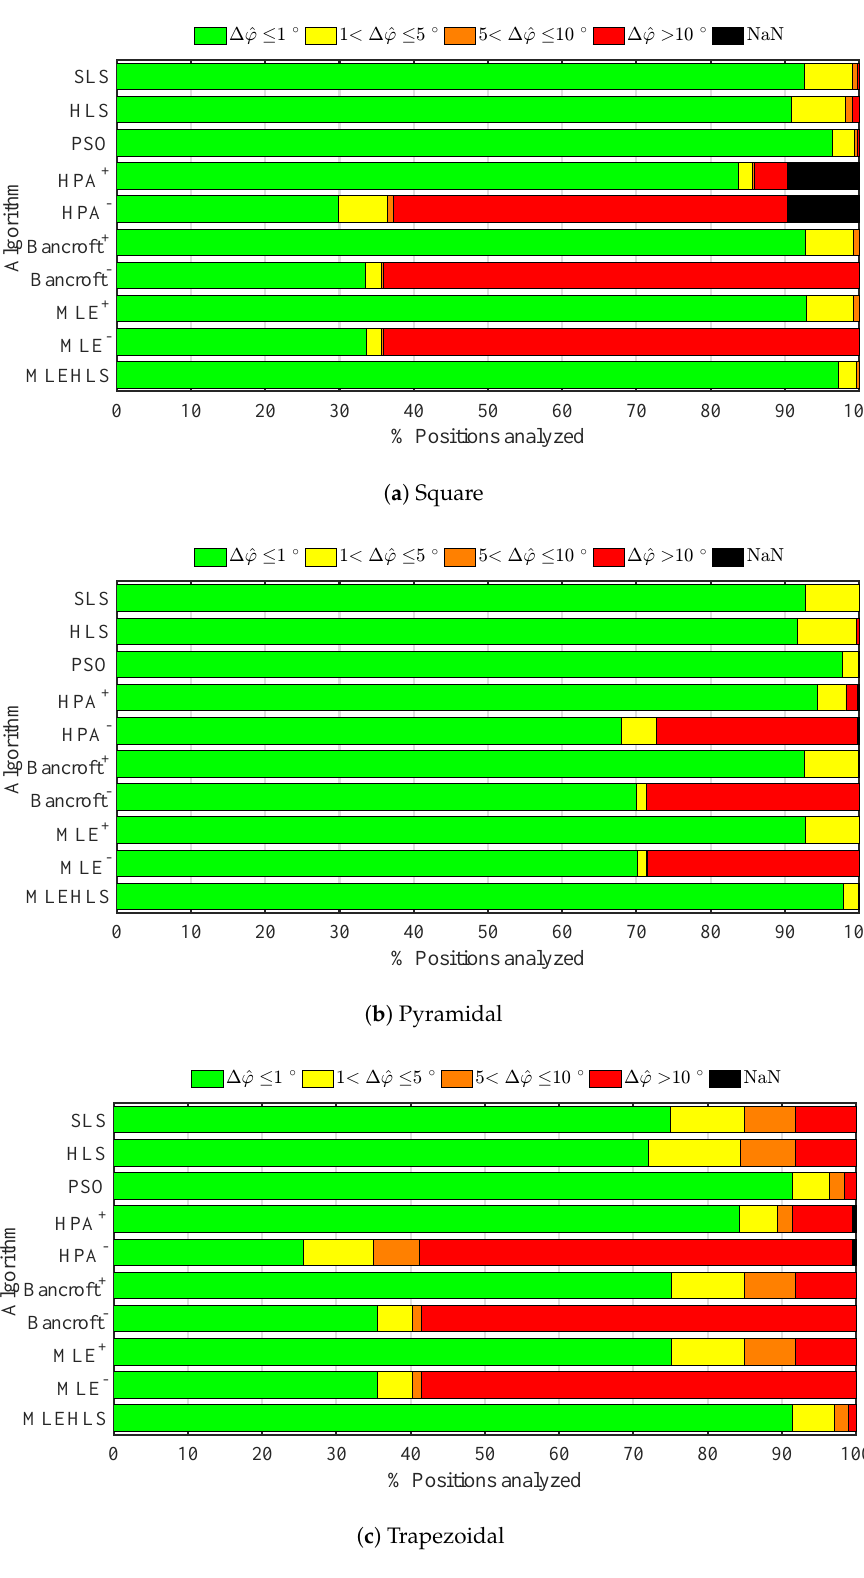
Figure 10. Percentage of positions located within the errors in the azimuth angle ∆ ˆ ϕ in degrees defined in the legend under digitizing error in time variables for each algorithm and antenna array